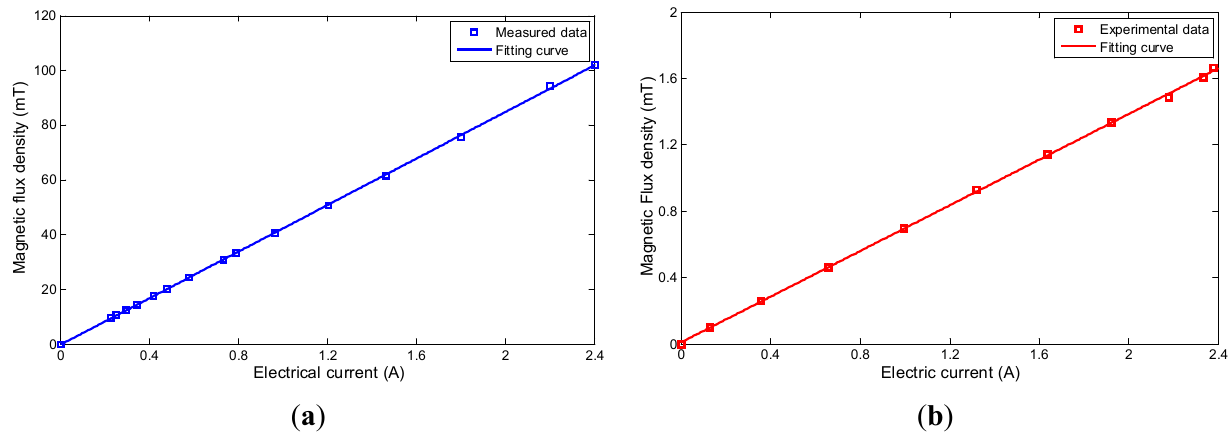
Figure 9. Magnetic flux density of Helmholtz coils. ( a ) Helmholtz coil with iron core; ( b ) Helmholtz coil without iron core.